Question: Name the type of graph shown.
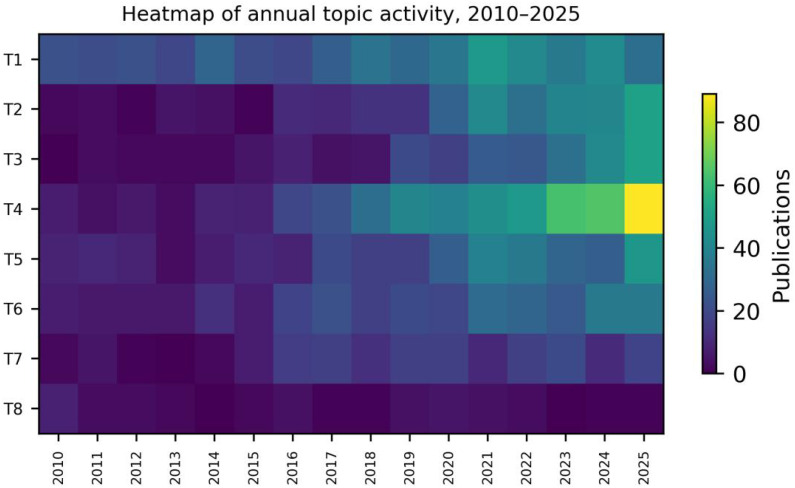
Answer: heatmap